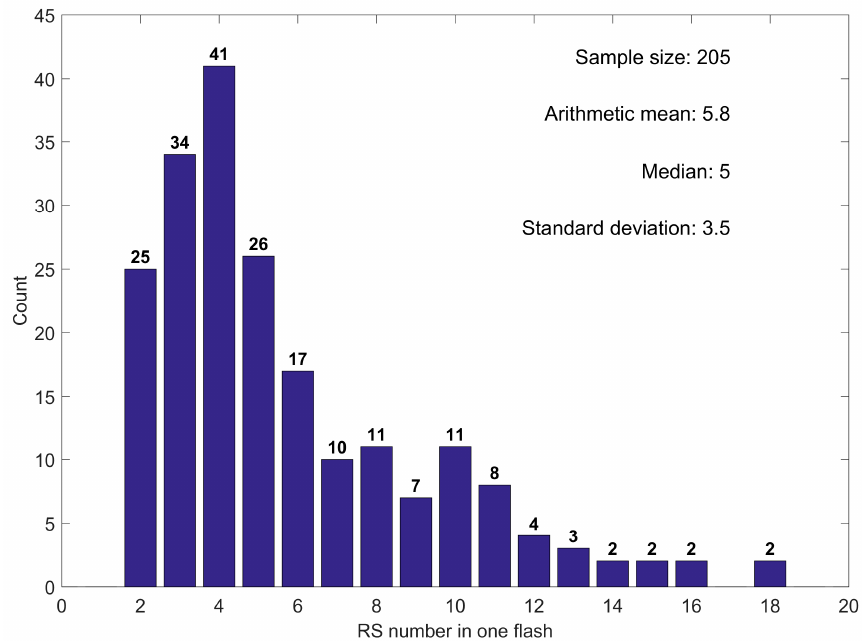
Figure 6. Histogram of RS numbers in each multiple-termination CG lightning flash.